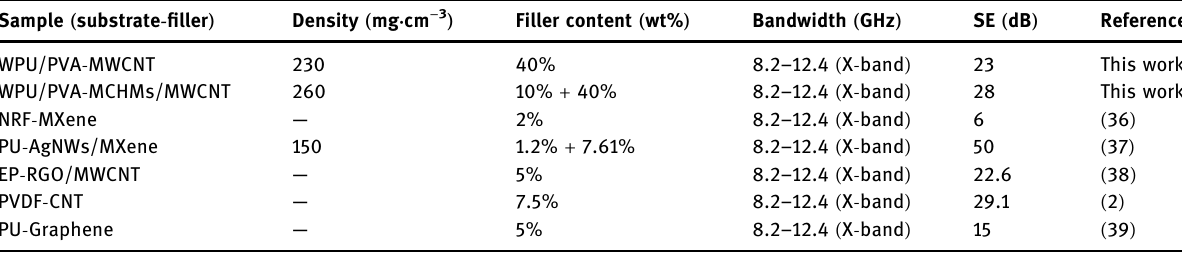
Table 2: Electromagnetic shielding performance of di ff erent carbon - based materials Sample ( substrate - fi ller